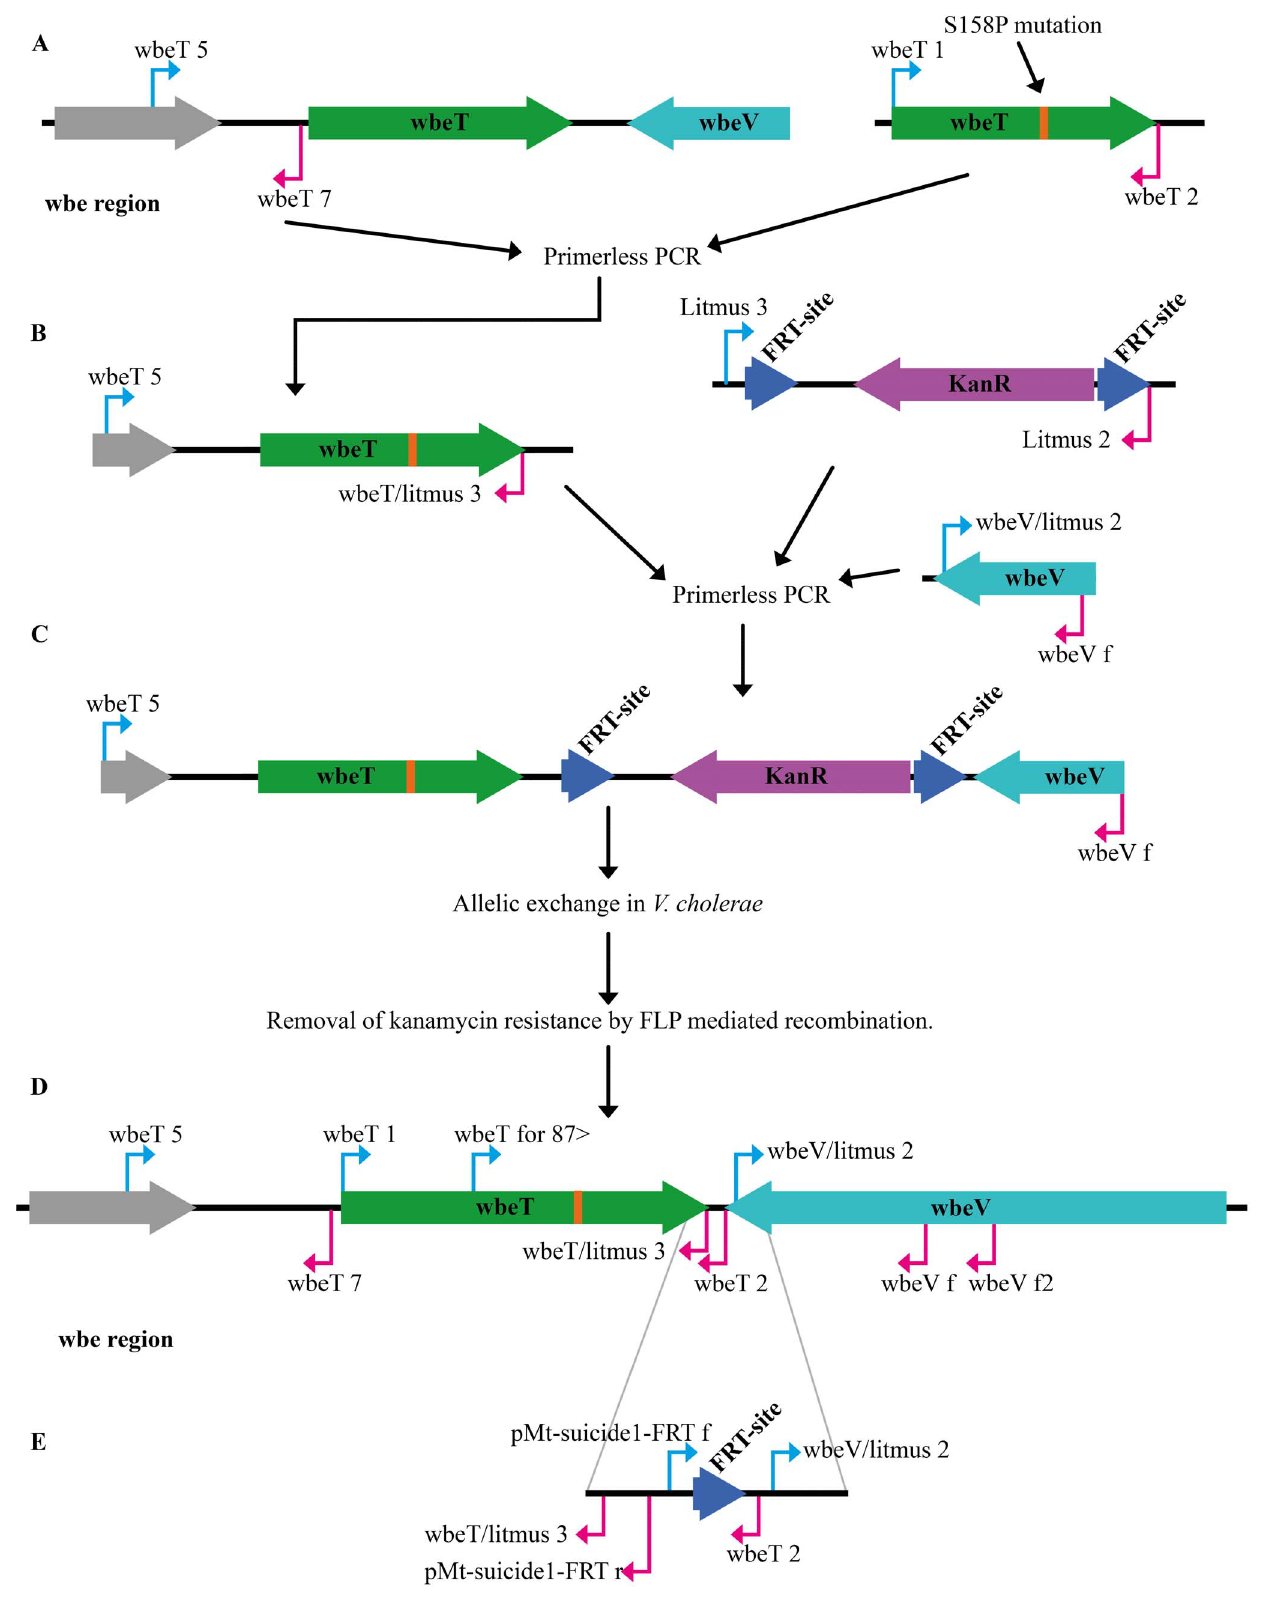
Figure 2. A schematic figure over the construction of the suicide plasmid and its incorporation into and it’s the removal from the genome. (A) Amplification of the mutated wbeT gene the upstream DNA was generated to be fused together in a primerless PCR. (B) The fused sequenced were used in another primerless PCR together with the kanamycin resistant gene flaked by FRT–sites and the downstream sequenced of